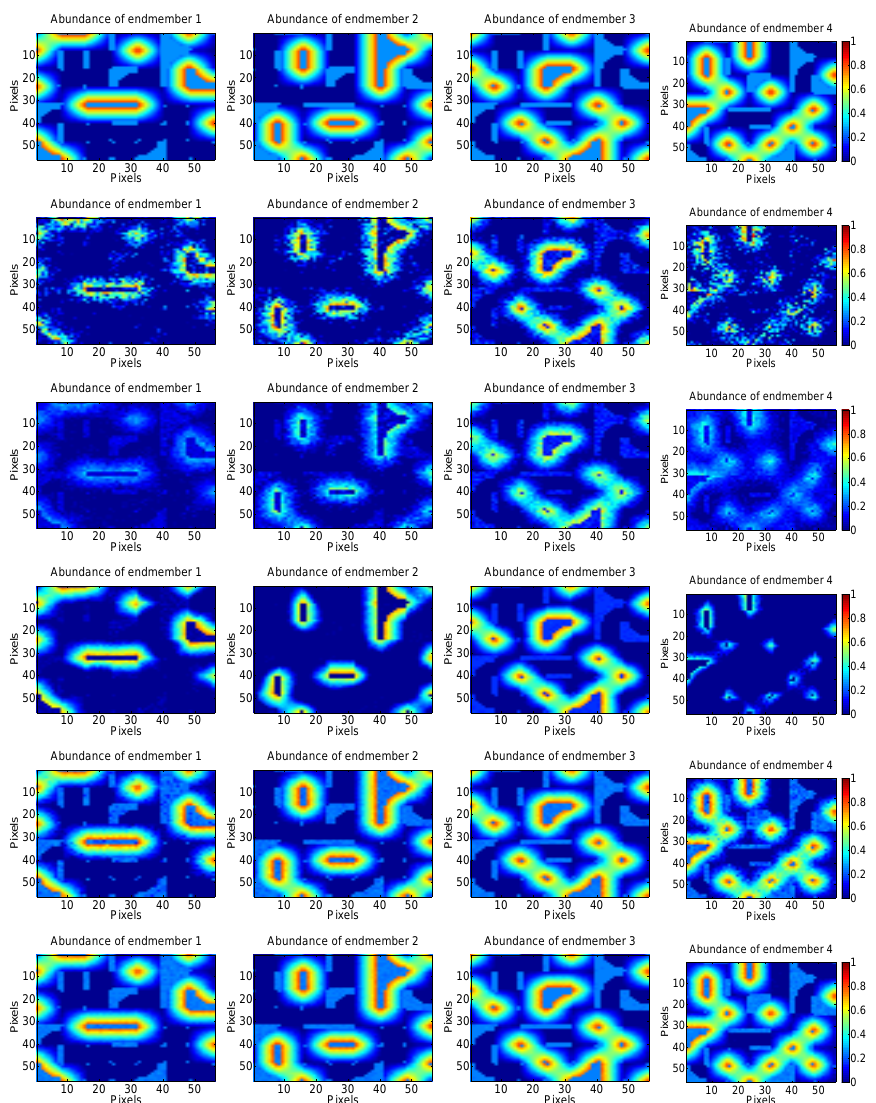
Figure 7. Abundance maps of four endmembers estimated with different methods under Gaussian white noise with only mixed regions having 64 × 64 pixels and 224 bands. From top to bottom: ground truth, SUnSAL ( λ = 10 − 2 ), CLSUnSAL ( λ = 1), CUSAL-SP ( λ = ˆ s × 10 − 5 ), SU-NLE ( d = 1) ( λ = 10 − 3 ) and SU-NLE ( d = 2) ( λ = 10 − 1